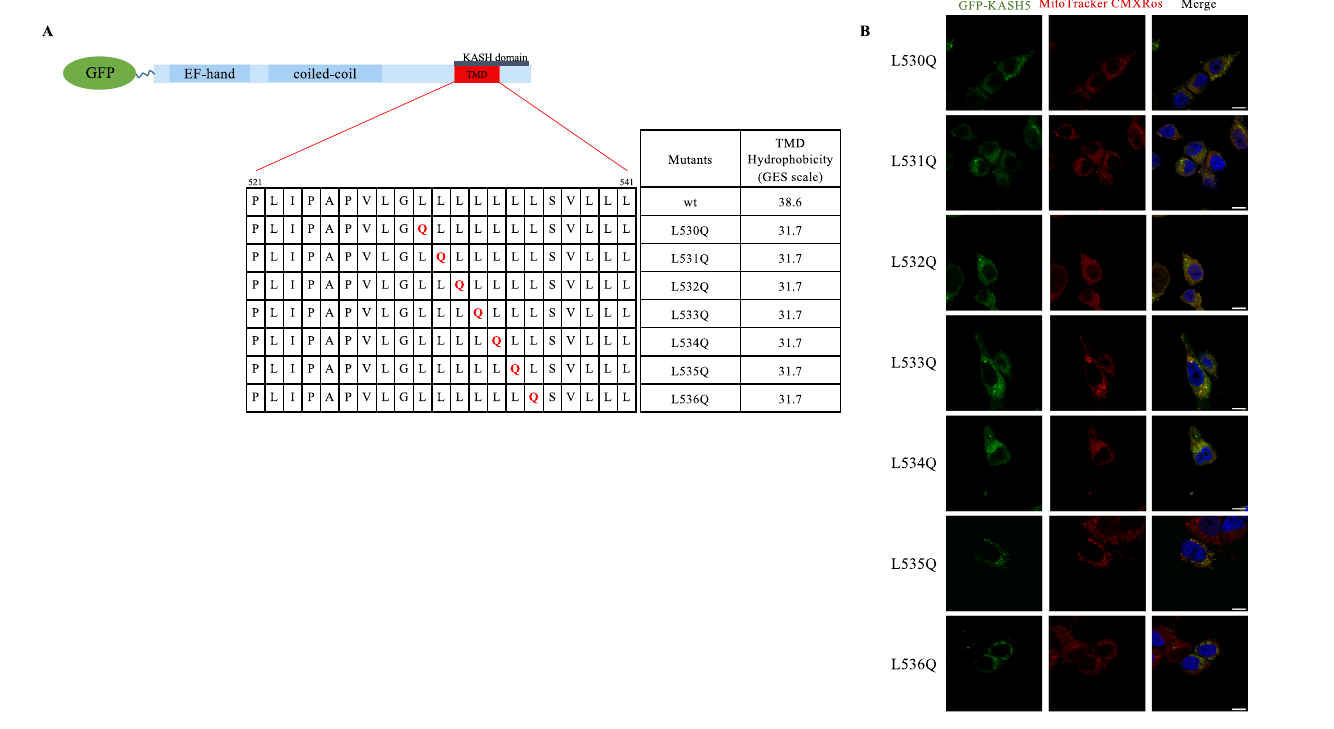
Figure 3. The position of the glutamine in the 7-leucine stretch does not disrupts the protein localization. ( A ) A schematic of KASH5 TMD indicating the sequential replacement of a leucine with a glutamine in the 7-leucine stretch. Computed according to the GES scale, all the variants have the same hydrophobicity of the TMD. ( B ) MCF-7 cells transfected with a N-terminal GFP-tagged version of KASH5 variants and treated with MitoTracker Red CMXROS to stain the mitochondria. All substitutions within the 7-leucine stretch lead to the mislocalization at the mitochondria. Scale bar 10 μm. The experiment was repeated two times.